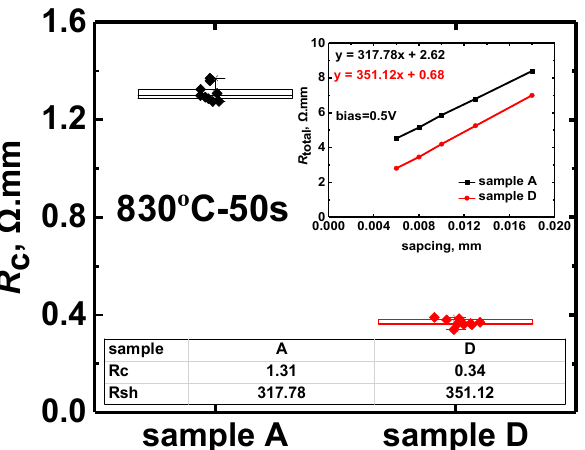
Figure 3. Ohmic contact resistance ( R C ) values of sample A and sample D. The inset shows a linear fit of total resistances of the TLM.